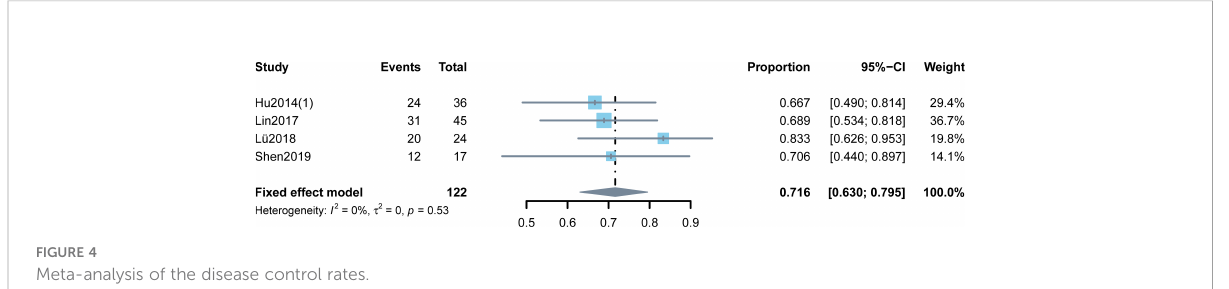
FIGURE 4 Meta-analysis of the disease control